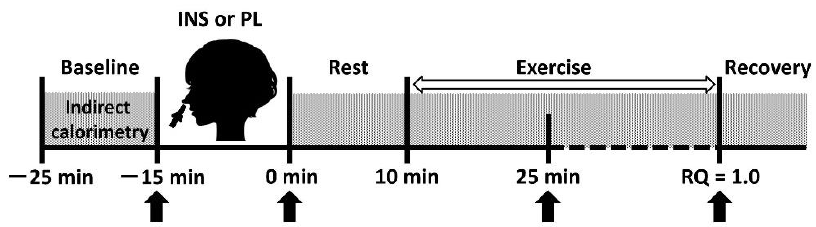
Figure 1. Experimental protocol. Hatched square indicates indirect calorimetry. Blood samplings are indicated by black arrows. Notes: INS, insulin; PL, placebo; and RQ, respiratory quotient.